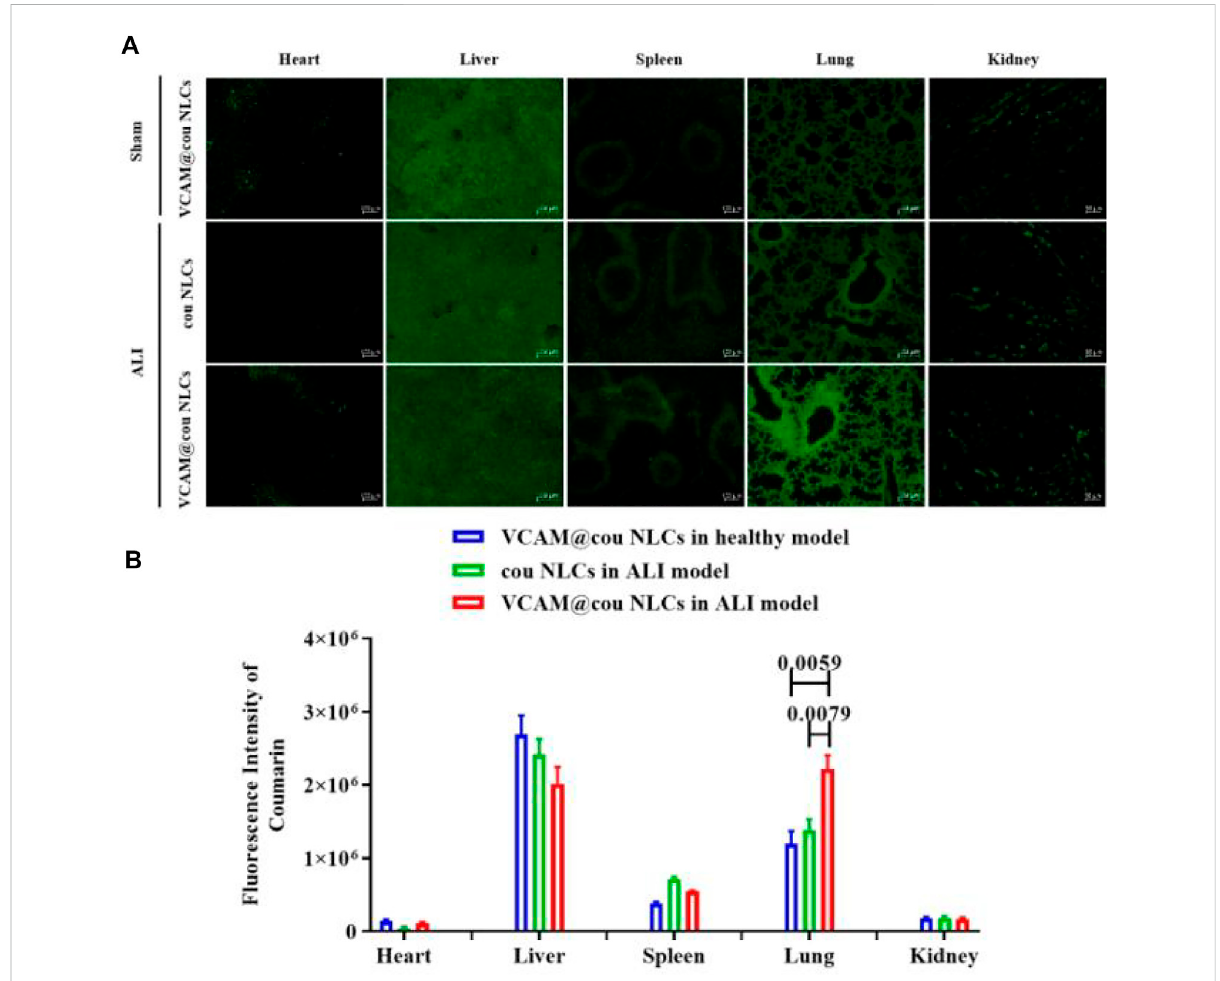
FIGURE 6 Bio-distribution ofVCAM-1antibody-conjugted NLCs. (A) Representative fl uorescence imagesofVCAM@couNLCs ineachorgan tissue (Scale bar, 100 μ m). (B) Semiquantitative analysis of fl uorescence intensity. ( n =